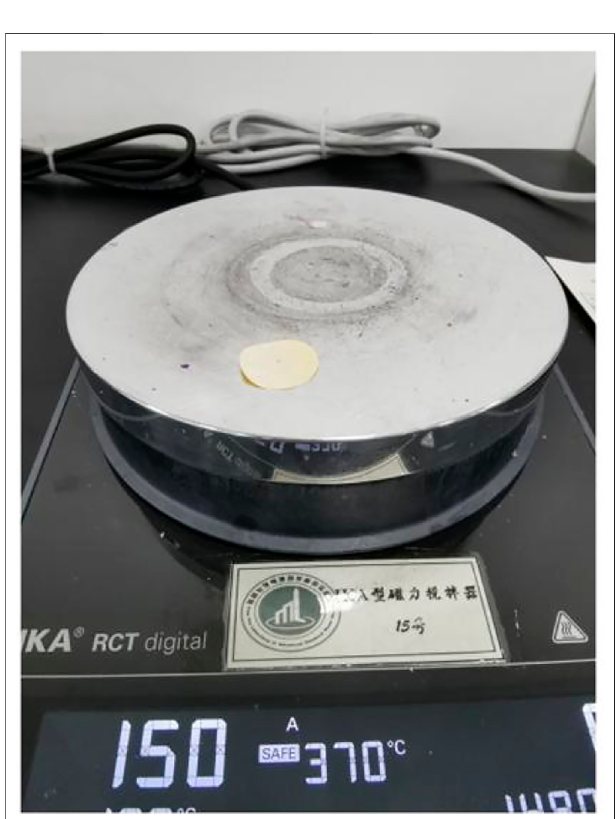
FIGURE5| Flexibleasymmetricorganic-inorganiccompositesolid-state electrolyte is heated at 150 ° C for 10 min.